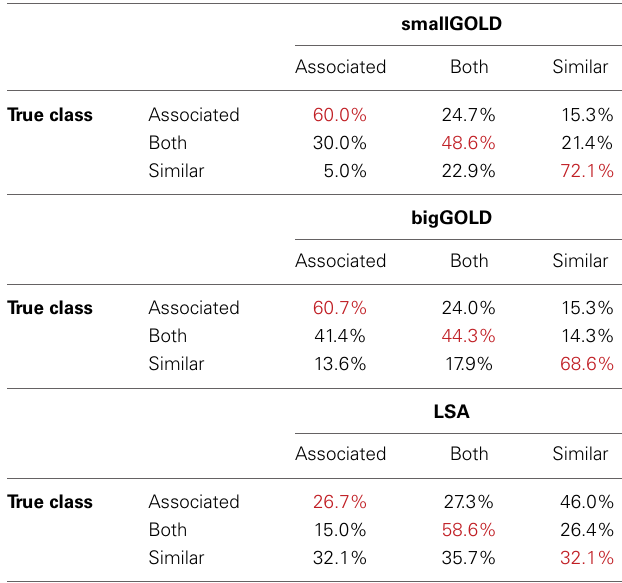
Table 5 | Classifier performance for the associated-only, both associated and similar, and similar-only word